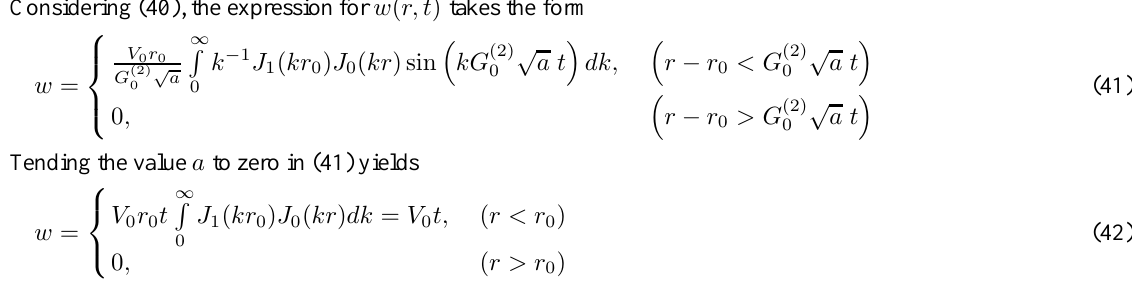
Fig. 4. The dimensionless time dependence of the dimensionless contact force and deflection at E θ /E r = 2 / 3 for a = 1 (curve 1), 0.75 (curve 2), 0.5 (curve 3), 0.25 (curve 4), and 0 (curve